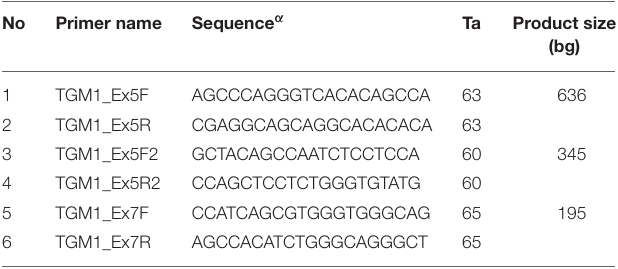
TABLE 2 | List of primers used for the novel TGM1 variants’ Sanger validation. No